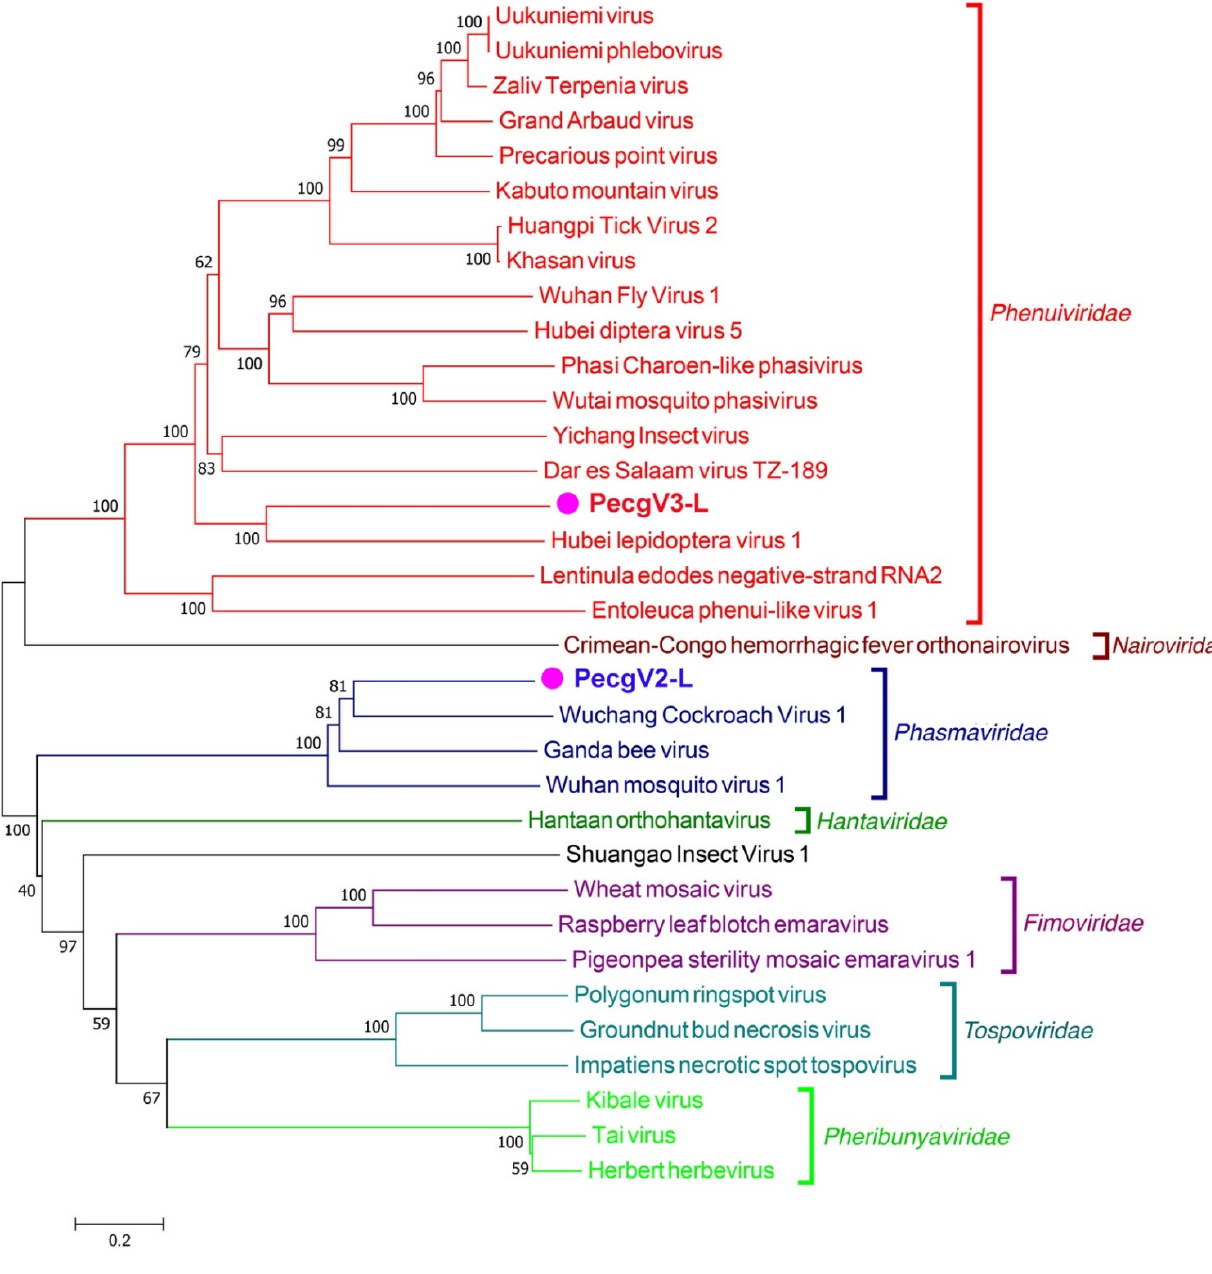
Figure 4. Phylogenetic trees of PecgV2 and PecgV3 with other ( − ss)RNA with RdRp sequences. The accession numbers for sequences are shown in File S1. The amino acid sequences were aligned using ClastalW, and then the tree was constructed using Mega 7.0 with neighbor-joining method and evaluated with 1000 bootstrap replicates.